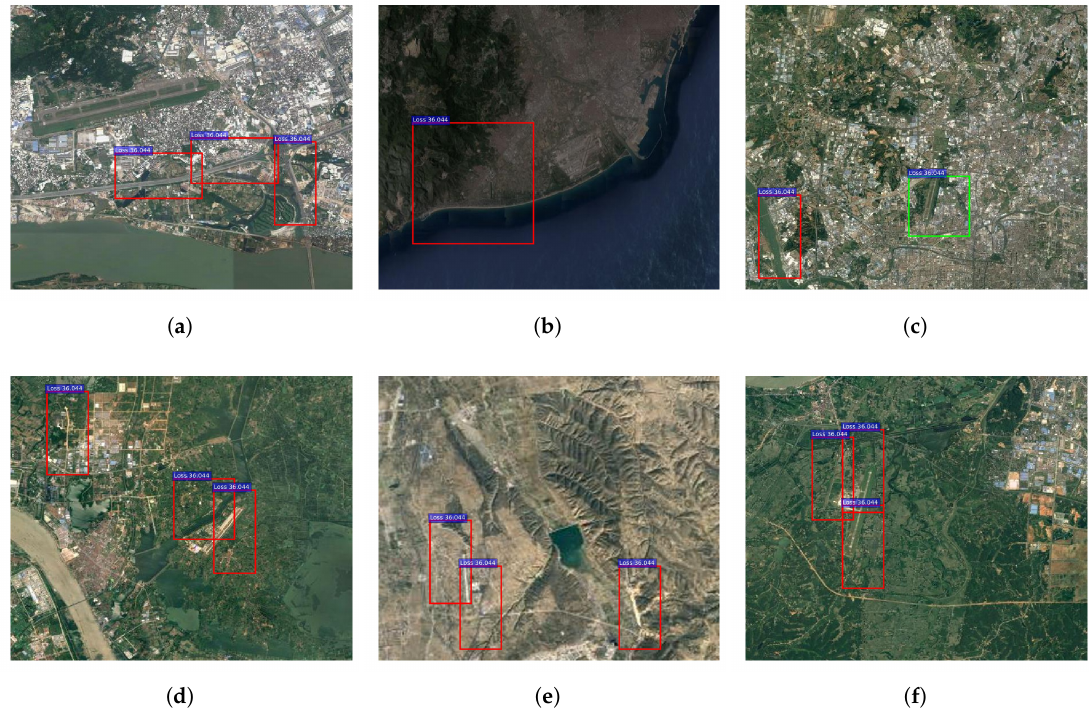
Figure 6. The 6-class hard examples. The positive and negative examples are indicated by green and red rectangles, respectively. ( a ) highway; ( b ) coastline; ( c ) riverbank; ( d ) salient roadway; ( e ) salient mountain ridge; ( f ) regions overlapped with airport .